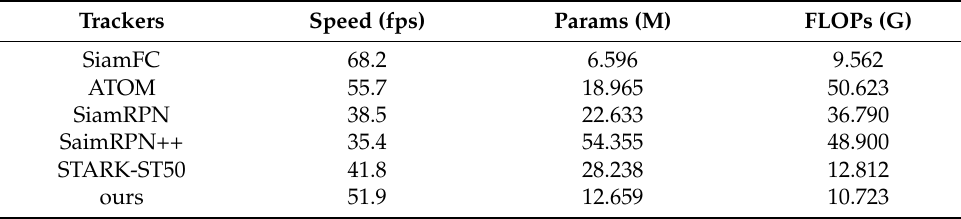
Table 9. Comparison of the speed, FLOPs, and